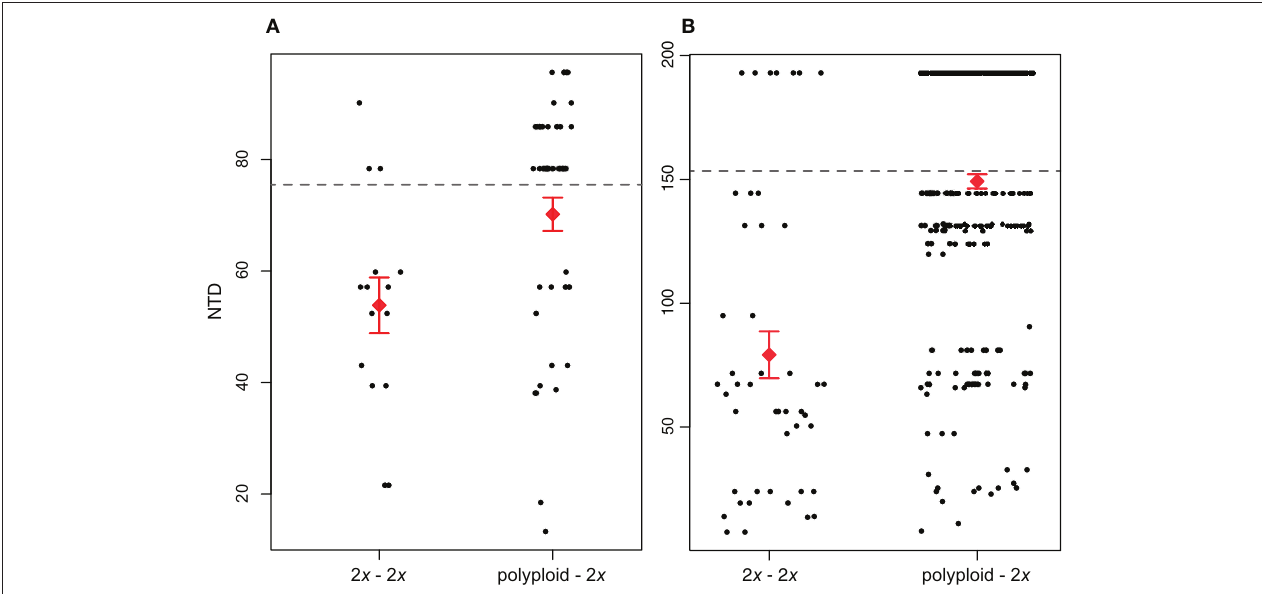
FIGURE 3 | Phylogenetic distance between diploids and their closest diploid relative (nearest taxon distance; NTD) within the same community (2 x – 2 x ) and NTD between polyploids and diploids within the same community (polyploid – 2 x ). NTD differences between the two groups are significant for both (A) Brassicaceae ( P < 0.05) and (B) Rosaceae ( P << 0.01). The red diamond and error bars show the mean of the distribution ± 1 standard error. The mean NTD (MNTD) for each family-level phylogeny is indicated by the dashed horizontal line.